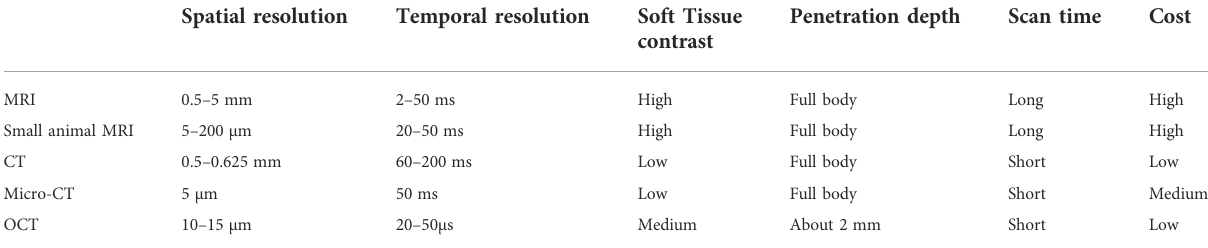
TABLE 1 Properties of different medical imaging